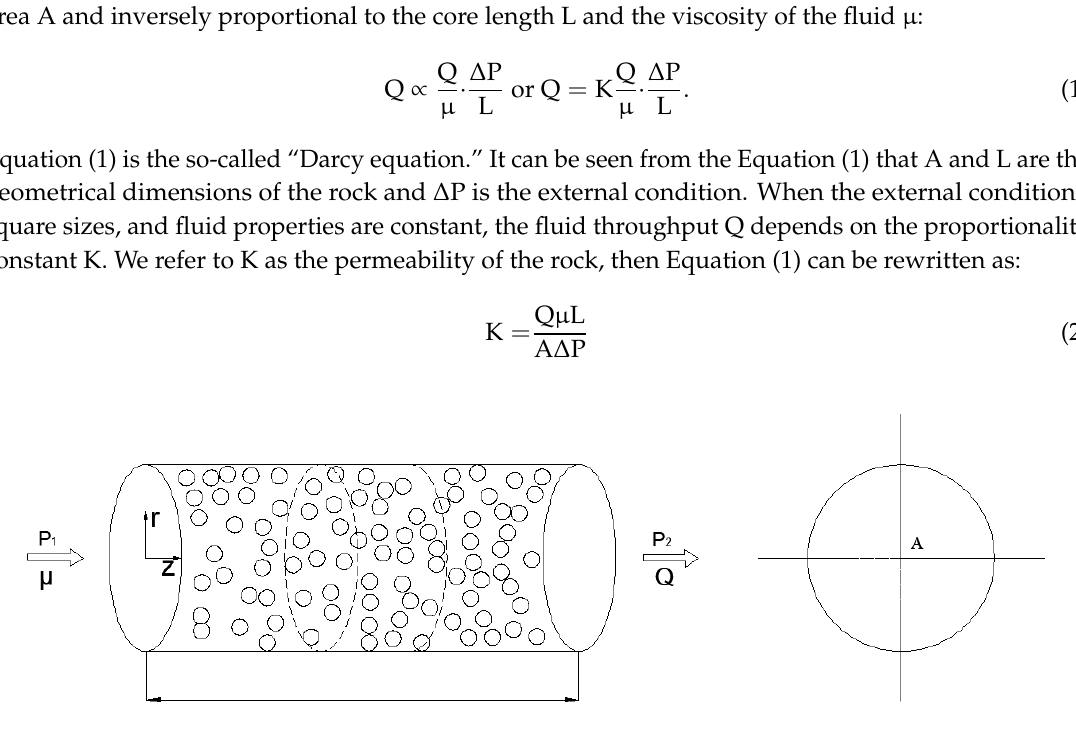
Figure 3. Permeability calculation model.